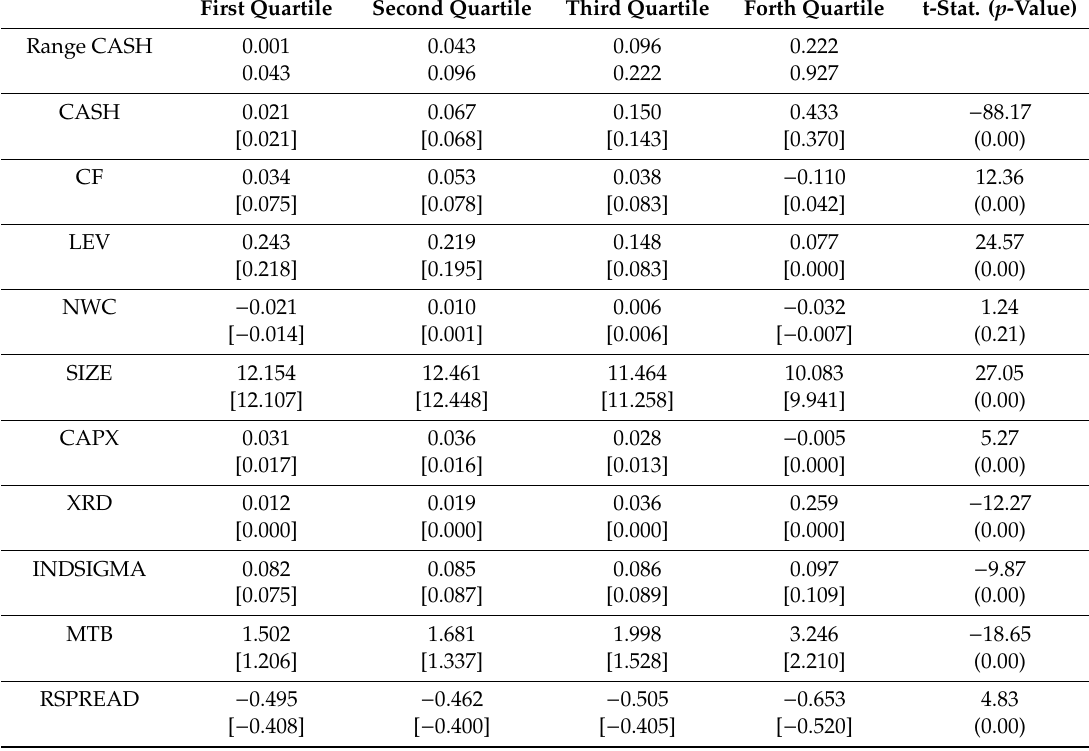
Table 5. Firms’ Characteristics by Cash to total assets (CASH)